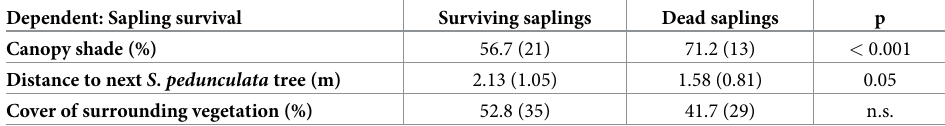
Table 1. Scalesia pedunculata sapling and young tree mortality was significantly correlated with percent canopy shade and distance to the next S . pedunculata tree, while percent cover of surrounding vegetation did not have a significant explanatory